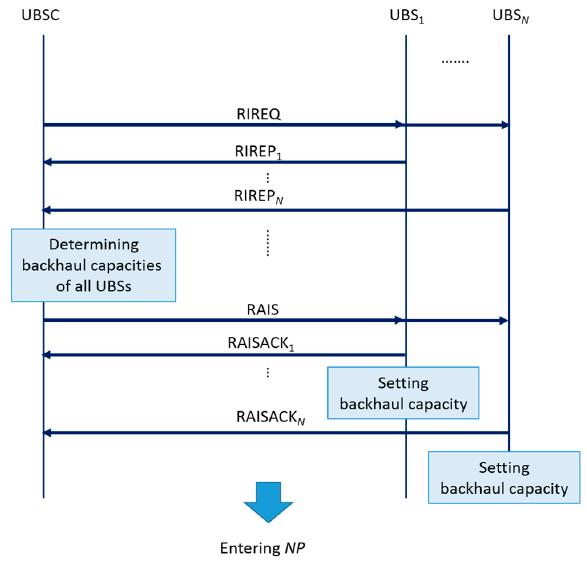
Figure 3. The initialization phase. RIREQ: Resource Information Request; RIREP: Resource Information Response; RAIS: Resource Allocation Information Send; RAISACK: Resource Allocation Information Send Acknowledgement; NP: normal operation phase.